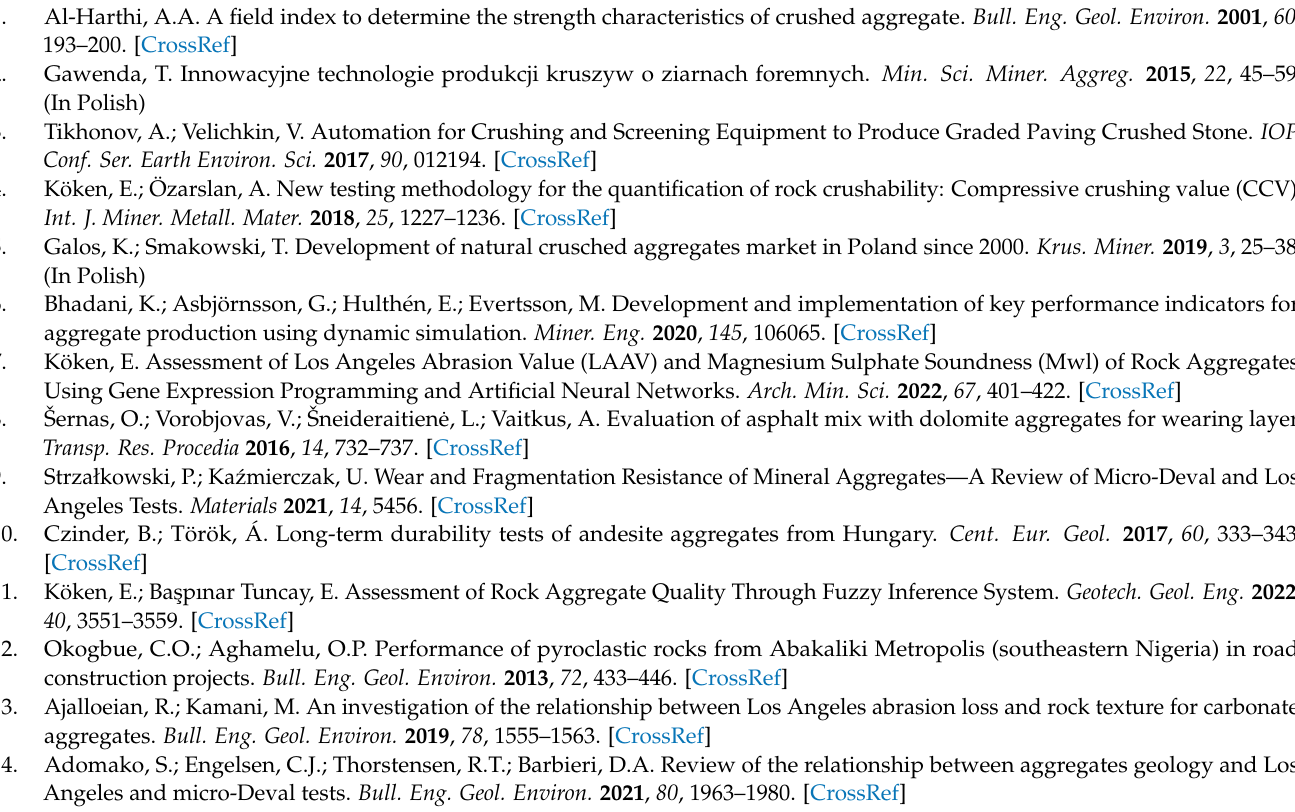
Figure A12. Characteristics of cracks in samples after crushing in cone crusher (feed—non-flaky grains): ( a ) Basalt aggregate 2, non-flaky grains, +8 mm; ( b ) Basalt aggregate 2, non-flaky grains, +16 mm; ( c ) Basalt aggregate 2, flaky grains, +8 mm; ( d ) Basalt aggregate 2, flaky grains, +16 mm. Al-Harthi, A.A. A field index to determine the strength characteristics of crushed aggregate. Bull. Eng. Geol. Environ. 2001 , 60 , 193 – 200. https://doi.org/10.1007/s100640100107.